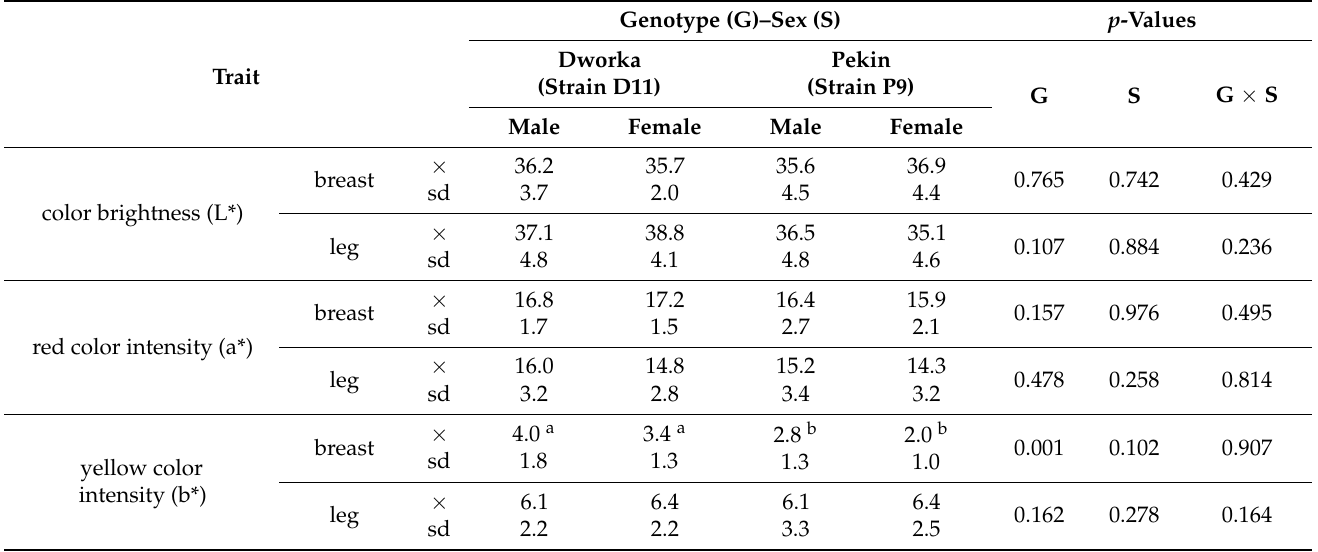
Table 4. Mean values ( × )and standard deviation (sd) of the color parameters of the breast meat and leg muscles of 113-week-old ducks.